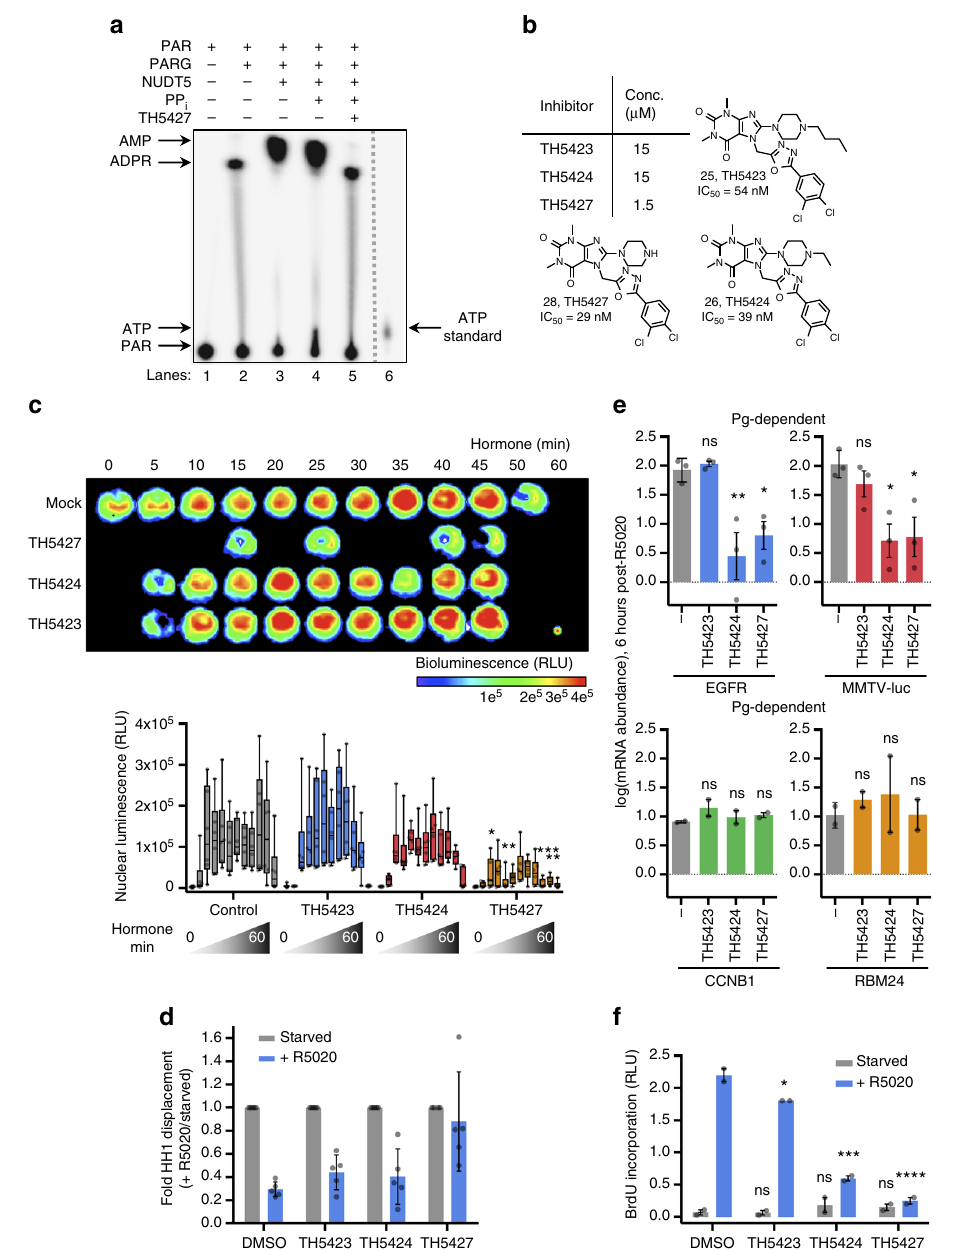
Fig. 4 TH5427 inhibits progestin-dependent nuclear ATP synthesis in breast cancer cells. a Representative thin layer chromatography (TLC) of products formed following processing of 32 P-PAR by recombinant PARG and NUDT5 in the absence or presence of TH5427 and PP i in vitro ( n = 2). b Concentrations and structures of inhibitors used in T47D WT/M cell culture experiments. c Serum-starved T47D WT cells expressing Nuc-luc FRTTO luciferase construct in the absence or presence of NUDT5 inhibitors prior to treatment with 10 nM R5020 and luminescence measurement. Top, a representative, pseudo-colored image of bioluminescence intensity over 60 min of R5020 treatment; bottom, box-and-whisker plots of bioluminescence quantitations from six independent experiments (center line, median; box limits, upper and lower quartiles; whiskers, minima and maxima; individual data points also shown). NS not signi fi cant, * p < 0.05, ** p < 0.01, *** p < 0.001; repeated measures two-way ANOVA analysis. Control, gray, TH5423, blue, TH5424, red, TH5427, orange. d Histone displacement was determined by chromatin immunoprecipitation (ChIP) using a histone H1-speci fi c antibody prior to (Starved, gray) or following 30 min of R5020 (+R5020, blue) in the presence or absence of NUDT5 inhibitors in T47D M cells. Data from a representative experiment is presented as mean fold change (+R5020/Starved) ± SD of fi ve different histone H1 contact regions. e Progesterone- dependent and – independent gene expression analysis in the presence or absence ( − ) of NUDT5 inhibitors following R5020 treatment (6 h) by RT-qPCR with T47D M cells. Data represents the mean ± SEM log(mRNA abundance) normalized to serum-starved cells without R5020 treatment from three (progesterone-dependent) or two (progesterone-independent) independent experiments. * p < 0.05, ** p < 0.01; one-way ANOVA analysis. f R5020- induced cell proliferation of T47D M cells in the absence or presence of NUDT5 inhibitors was assayed by BrdU incorporation after 24 h. Mean ± SEM of individual BrdU chemiluminescence signals are displayed without R5020 treatment (Starved, gray) and following R5020 treatment (+R5020, blue) from two independent experiments. RLU; relative luminescence units. ** p < 0.01, **** p < 0.0001; one-way ANOVA